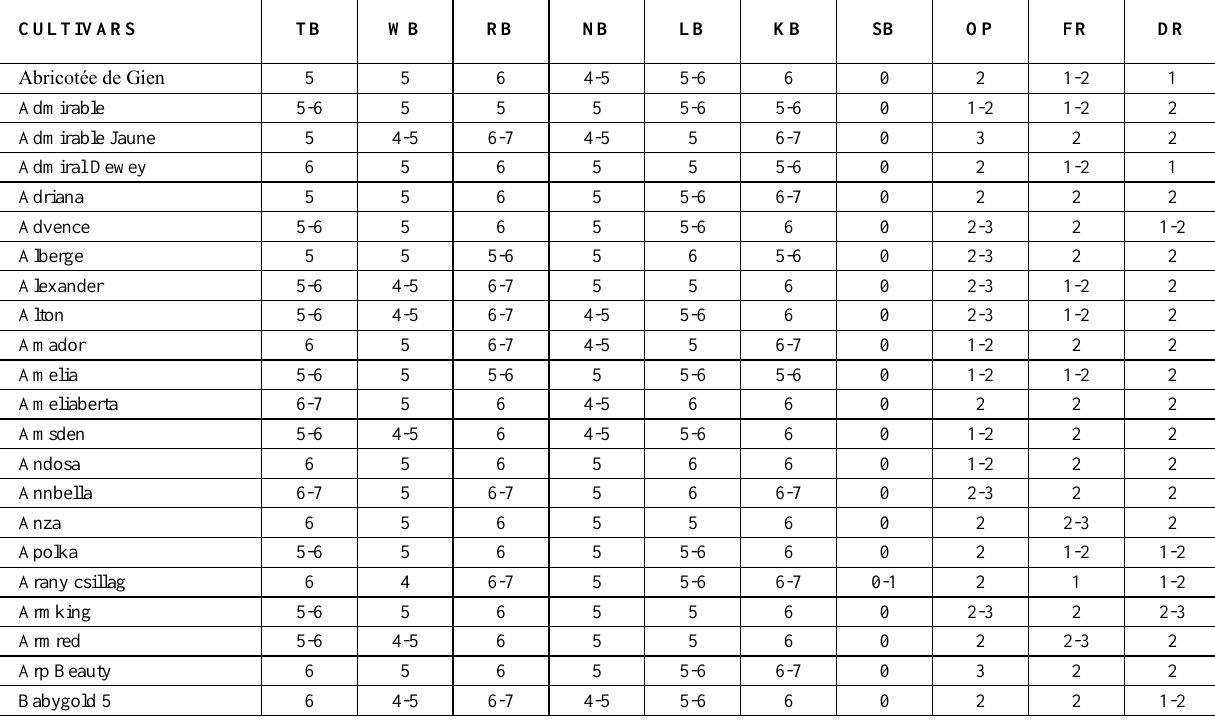
Table 1. Relative ecological and biological indicator values of each cultivars